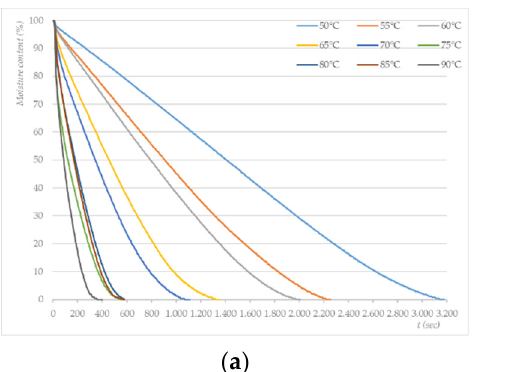
(average N 0 = 1.18 × 10 8 CFU/mL); ( b ) magnification of the first 60 s of treatment.